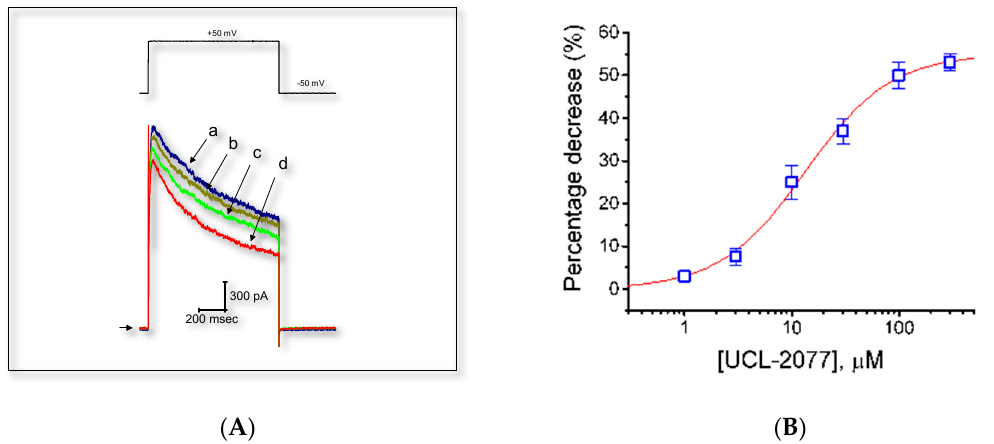
Figure 5. Effect of UCL-2077 on I K(DR) in GH 3 cells. In these experiments, we bathed cells in Ca 2+ -free Tyrode’s solution, which contained 1 µ M TTX to suppress Na + current, and backfilled the pipette with K + -containing solution. ( A ) Representative I K(DR) traces elicited by step depolarization (indicated in the upper part) were obtained in the absence (a) and presence of 3 (b), 10 (c), or 30 µ M (d) UCL-2077. ( B ) Concentration-response curve for UCL-2077-induced inhibition of I K(DR) in these cells. The peak amplitude of I K(DR) measured at the end of depolarizing voltage step during exposure to UCL-2077 was compared with the control value (mean ± SEM, n = 8 for each point). The smooth line represents the best fit to the modified Hill equation (equation (1)). The values for IC 50 , the Hill coefficient, and maximally inhibited percentage of I K(DR) were 13.4 µ M, 1.1, and 55%, respectively.